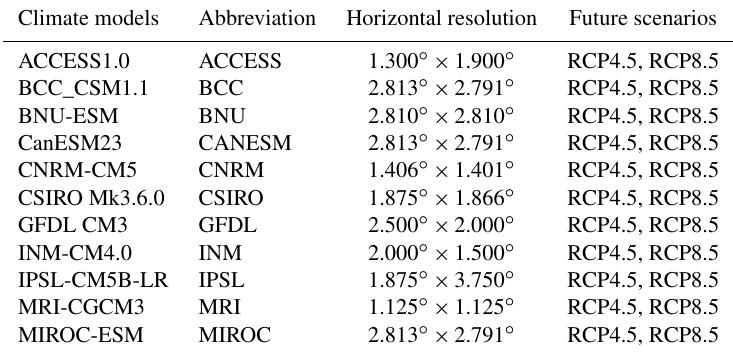
Table 1. Details of CMIP5 climate models applied in this study.